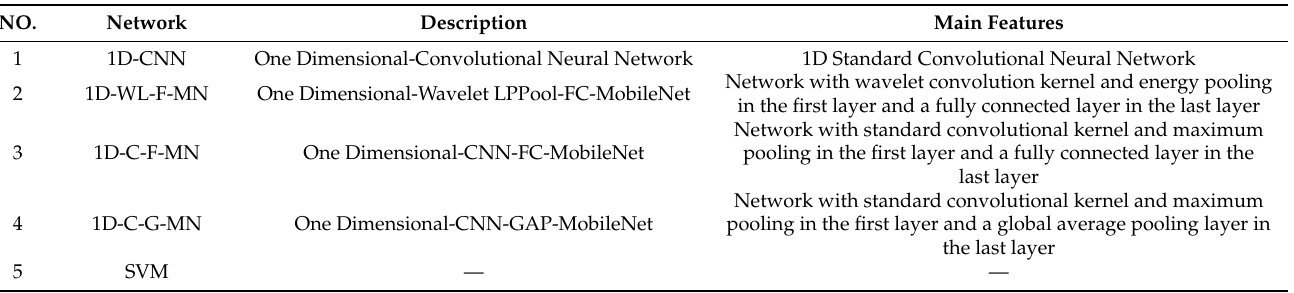
Table 4. Description of the different model structures.